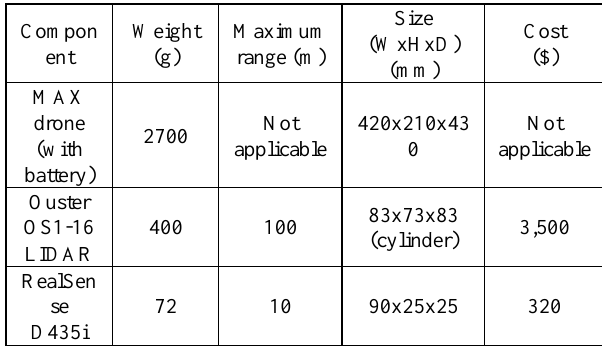
Table 2. The main components of the MAX drone. Raspberry Pi 4B using the robot operating system (ROS 7 ) and Georgia Tech Smoothing and Mapping (GTSAM 8 )